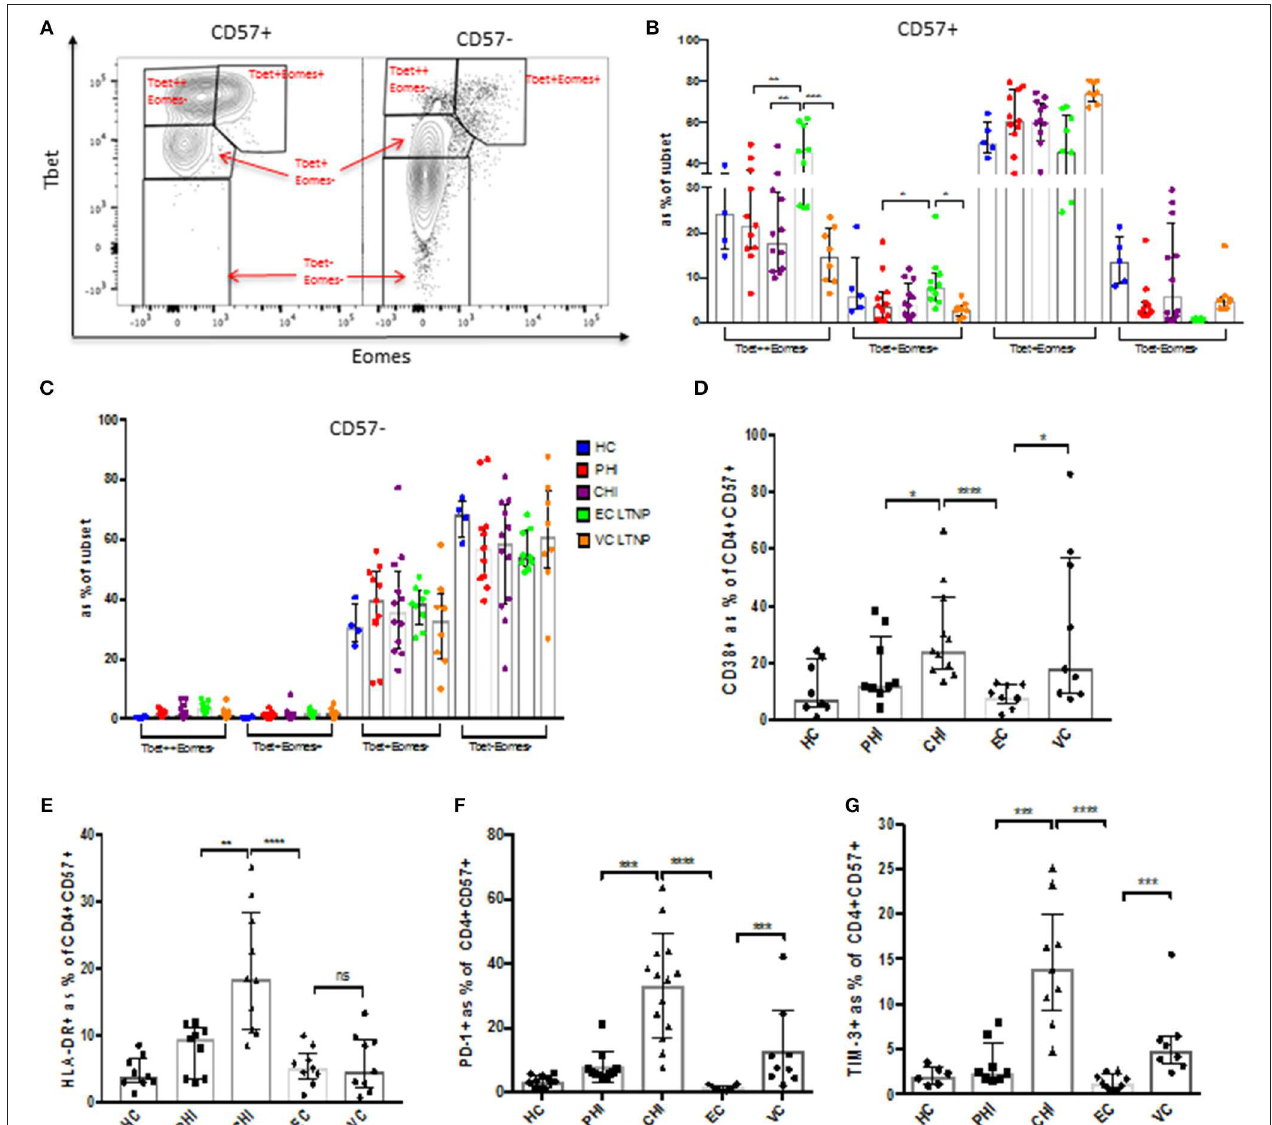
FIGURE 5 | CD57 + CD4 CTLs have a Tbet high Eomes + phenotype. (A) Representative dot plot of Tbet vs. Eomes expression. (B,C) Tbet and Eomes expression in CD57 + and CD57 − in CD4 + cells during different stages of HIV infection. (D) CD38 expression. (E) HLA-DR protein levels. (F) PD-1 inhibitory receptor expression.